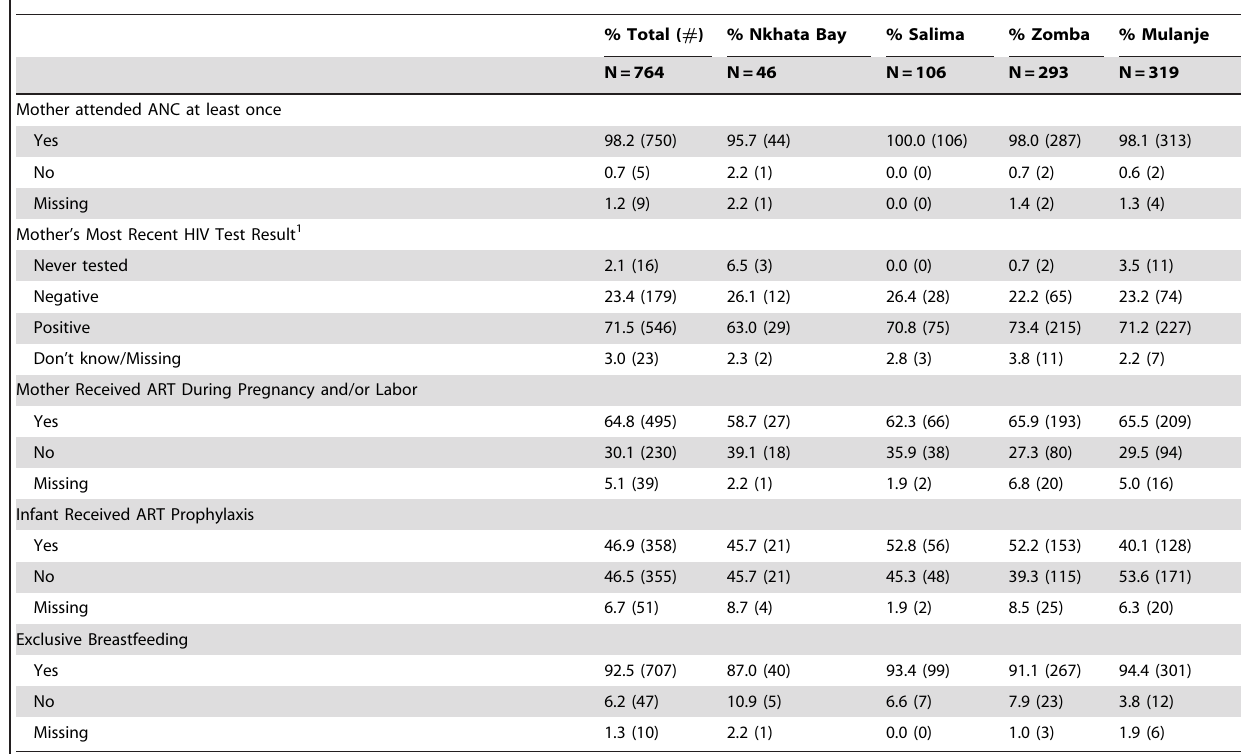
Table 1. Self-Reported Participation in PMTCT Activities among HIV-infected Mothers.